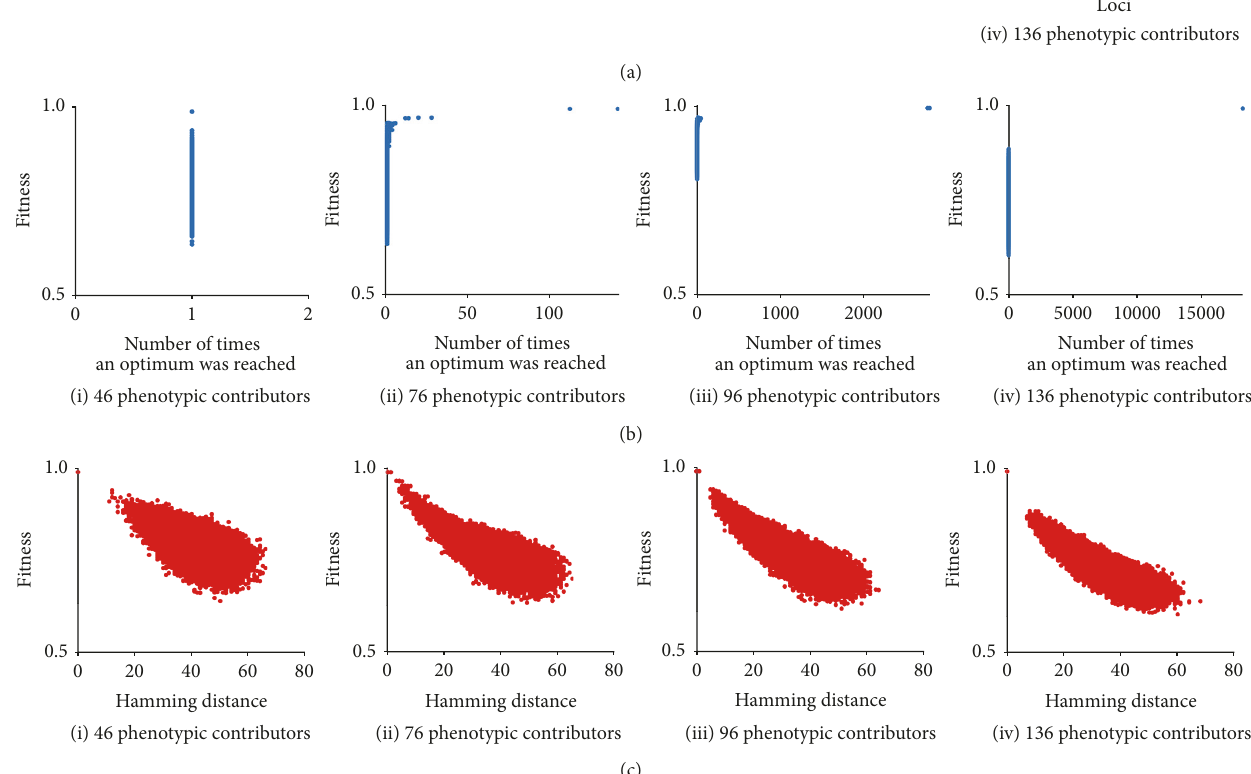
Figure 5: Comparison of numbers of phenotypic contributors for interaction map: (a) comparison of examples of interaction map relative dimensions. (b) Comparison of basin sizes by accessibility of local optima. For each of the four interaction maps 100,000 adaptive walks were used to discover the accessibility of the fitness landscape’s local optima. (c) Comparison of hamming distances from fittest optima. For each of the four interaction maps 100,000 adaptive walks were used to discover optima and the hamming distance of the fittest optima to all other optima versus optima fitness plotted. The four interaction maps compared are (i) 46 phenotypic contributors, (ii) 76 phenotypic contributors, (iii) 96 phenotypic contributors, and (iv) 136 phenotypic